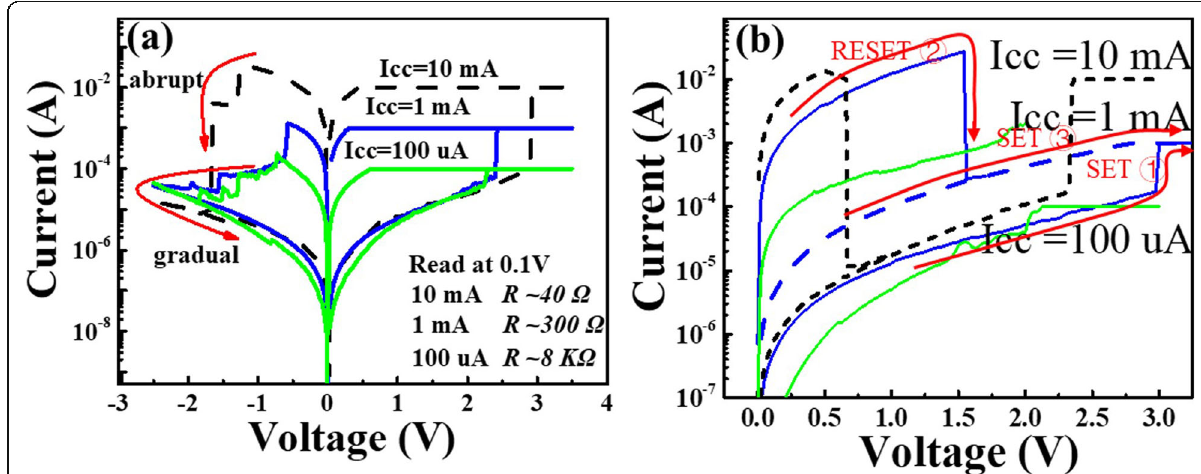
Fig. 4 a The I-V curves of the bipolar at different compliance currents: Icc = 10 mA (dotted line), Icc = 1 mA (blue line) and Icc = 100 uA (green line). The LRS resistance at different compliance currents at read 0.1 V (Icc = 10 mA, RLRS ~ 40 Ω ; Icc =1 mA, RLRS ~ 300 Ω ; Icc =100 uA, RLRS ~ 8 K Ω ). b The I-V curves of the unipolar behaviour at different compliance currents: Icc = 10 mA (dotted line), Icc = 1 mA (blue line) and Icc = 100 uA (black